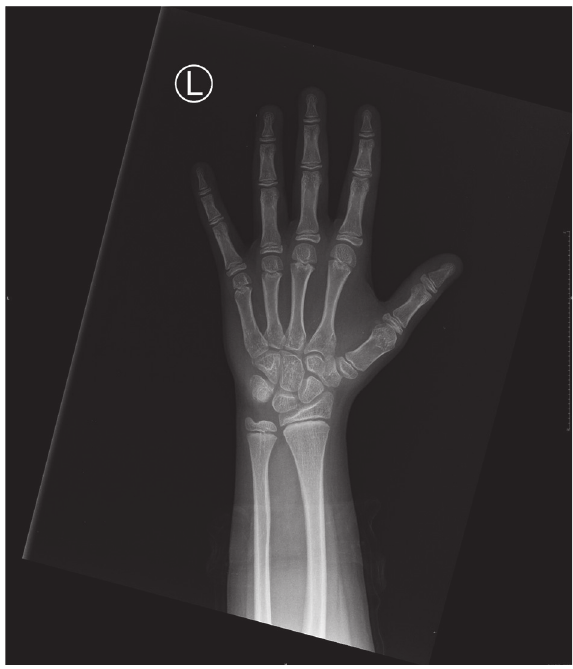
Figure 1: PA radiograph of the left hand for bone age evaluation. A radiograph of the left hand is depicted. The patient’s chronological age at the time of the evaluation was 12 years and 2 months. According to the second edition of Greulich and Pyle, the patient’s bone age is 11 years. Also noted is a short first metacarpal bone. The remaining bones have normal morphology. There is normal bone mineral